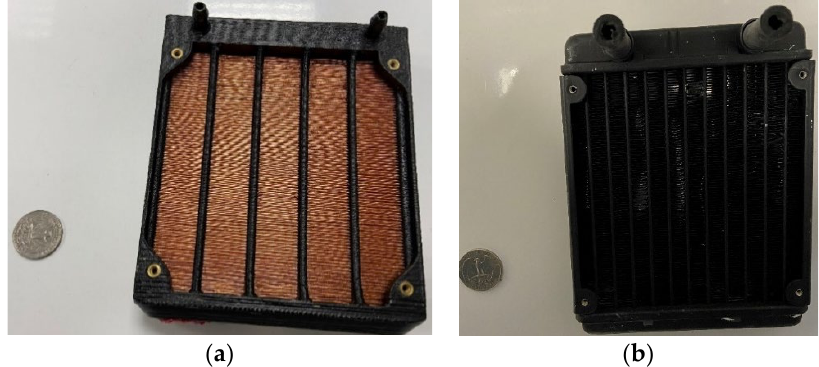
Figure 2. ( a ) Additively manufactured iCMHX and ( b ) conventional CPU radiator.